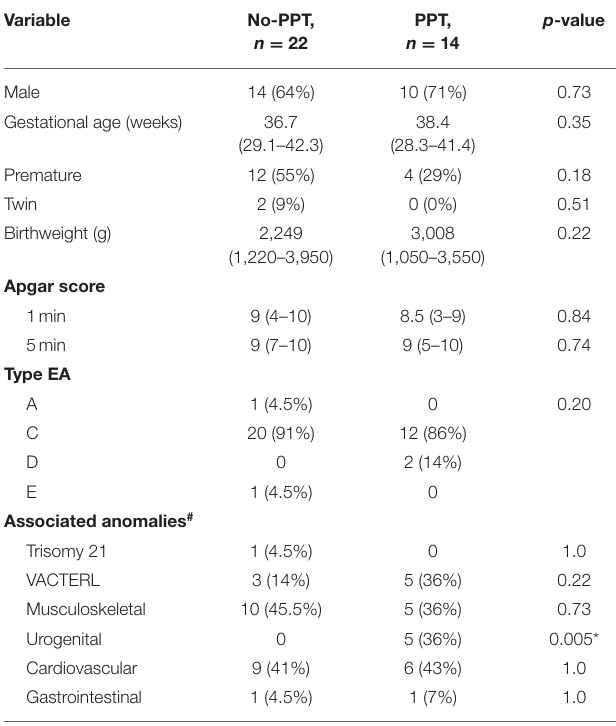
TABLE 2 | Patient characteristics of group 2 (2017–2019).